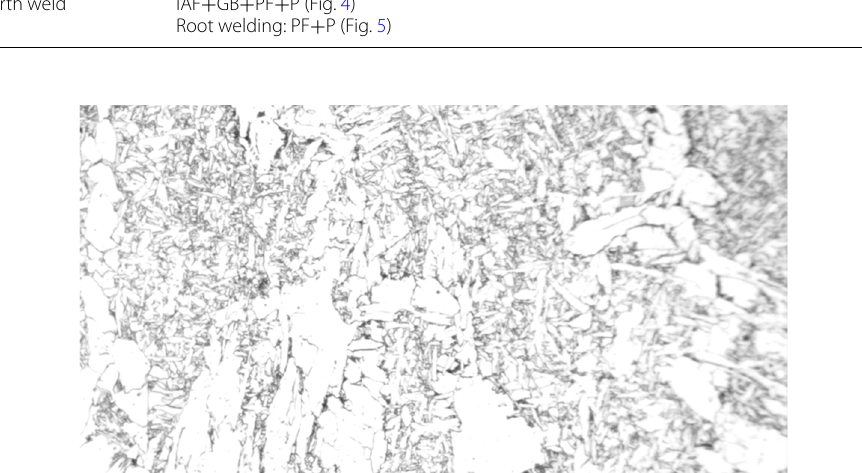
Table 10 Test results of weld samples without crack Item Weld microstructure No cracks Girth weld